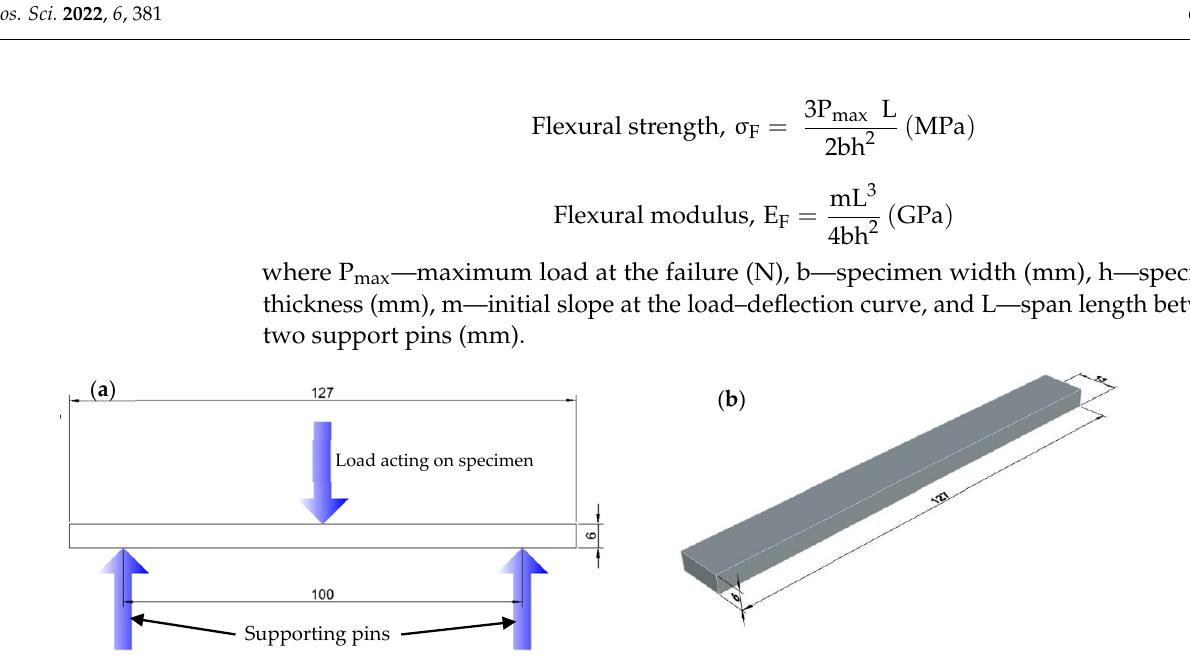
Figure 2. ( a ) Experimental setup of flexural test. ( b ) Isometric view of the bending specimen.